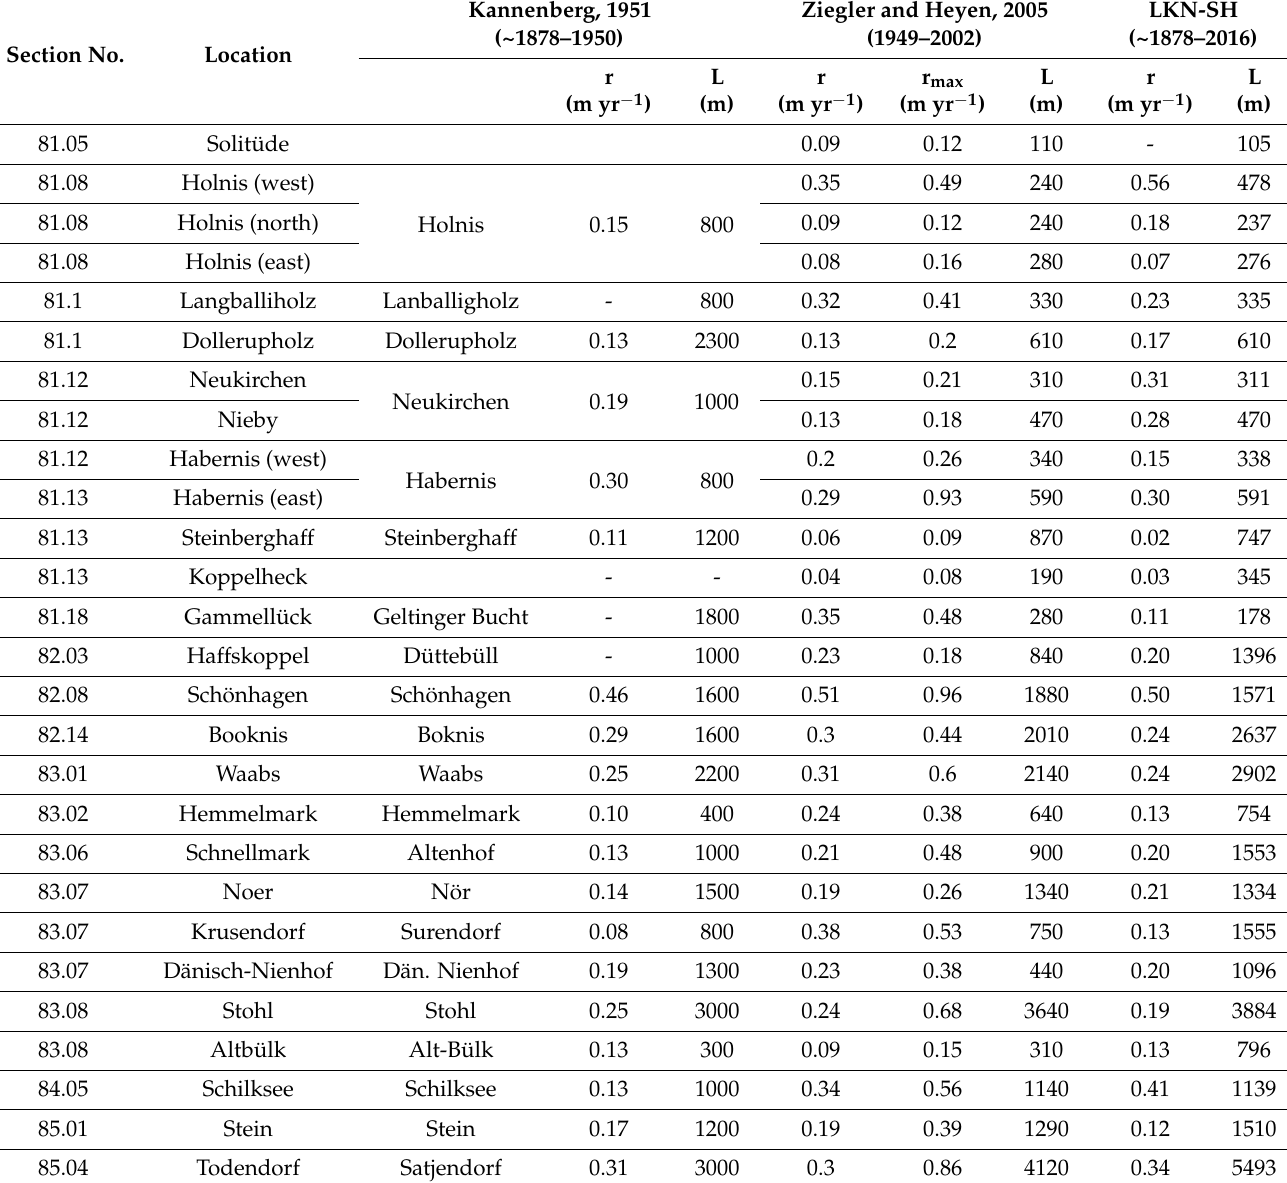
Table A1. Compilation of Cliff Retreat along the Baltic Sea coast of S-H, Germany, based on data from [8,36,52].